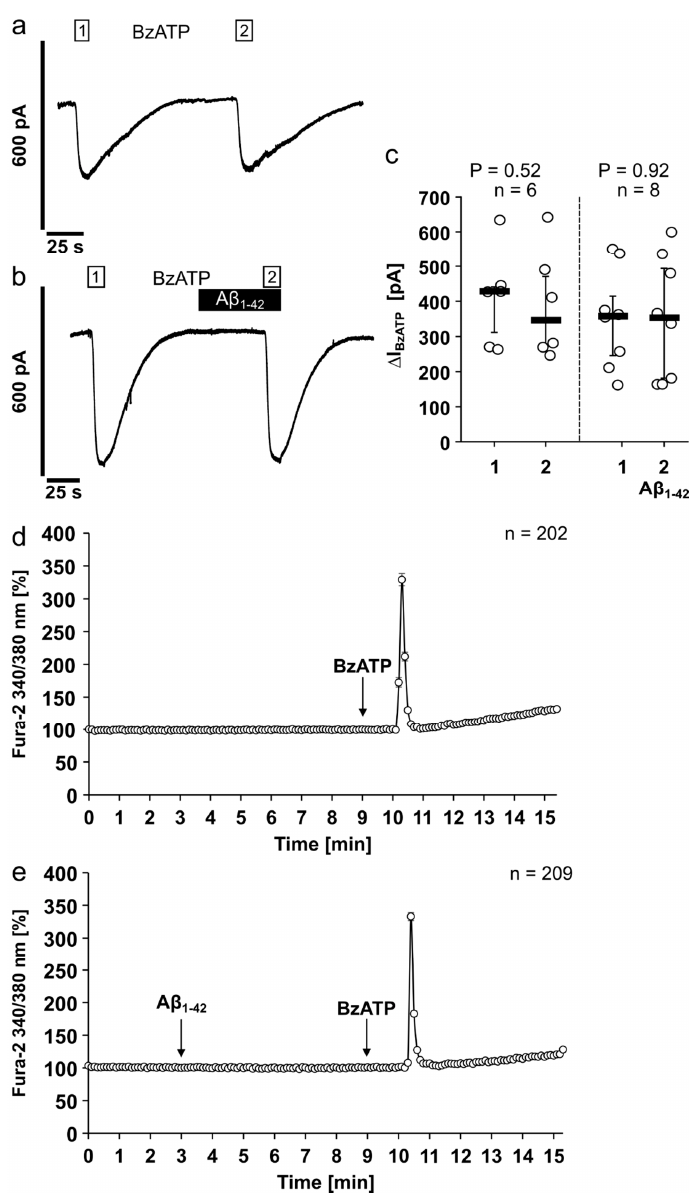
Figure 4. Amyloid beta peptide (A β 1-42 ) has no impact on the ion channel activity of the human P2X7 receptor. ( a – c ) Whole-cell patch-clamp measurements were performed on HEK293 cells overexpressing human P2X7 receptor (HEK-P2X7R cells). ( a , b ) Depicted are representative current traces. ( a , c ) In control experiments, consecutive application of the P2X7 receptor agonist BzATP (100 µ M, white bar) induced repetitive current stimulations (BzATP1 and 2). ( b , c ) After washout of the first BzATP stimulus, A β 1-42 (5 µ M, black bar) was applied and did not induce changes in ion currents. In the presence of A β 1-42 , BzATP induced repetitive current stimulations. ( c ) All BzATP-induced current changes ( ∆ I BzATP ) are shown as individual data points, bar represents median, whiskers encompass the 25th to 75th percentile. Statistical analyses were performed using the Friedman test followed by the Wilcoxon signed-rank test. ( d , e ) Calcium imaging experiments were performed on HEK-P2X7R cells. Intracellular calcium concentrations ([Ca 2 + ] i ) of HEK-P2X7R cells were recorded as Fura-2 / AM (Fura-2) fluorescence intensity ratio of 340:380 nm excitation. For graphical representation and statistical analyses, signal intensities at time point 3 min were set to 100%, and all other values were calculated in accordance and are presented as mean ± SEM. ( a ) In control experiments, application of the P2X7 receptor agonist BzATP (100 µ M) induced a rise in [Ca 2 + ] i . ( b ) A β 1-42 (5 µ M) did not alter the [Ca 2 + ] i . In the presence of A β 1-42